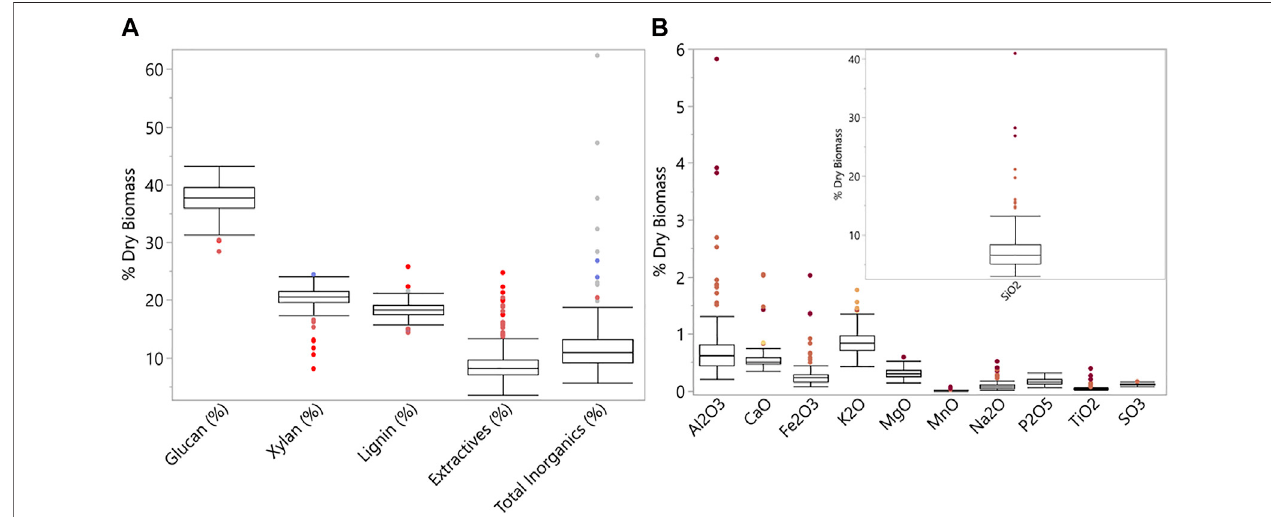
FIGURE2| Boxplotsfor (A) chemicalcomposition; n =222,and (B) inorganicspeciation; n =191.SiO 2 isbroken outforaclearer viewofthevariablerangesofthe other inorganic species.